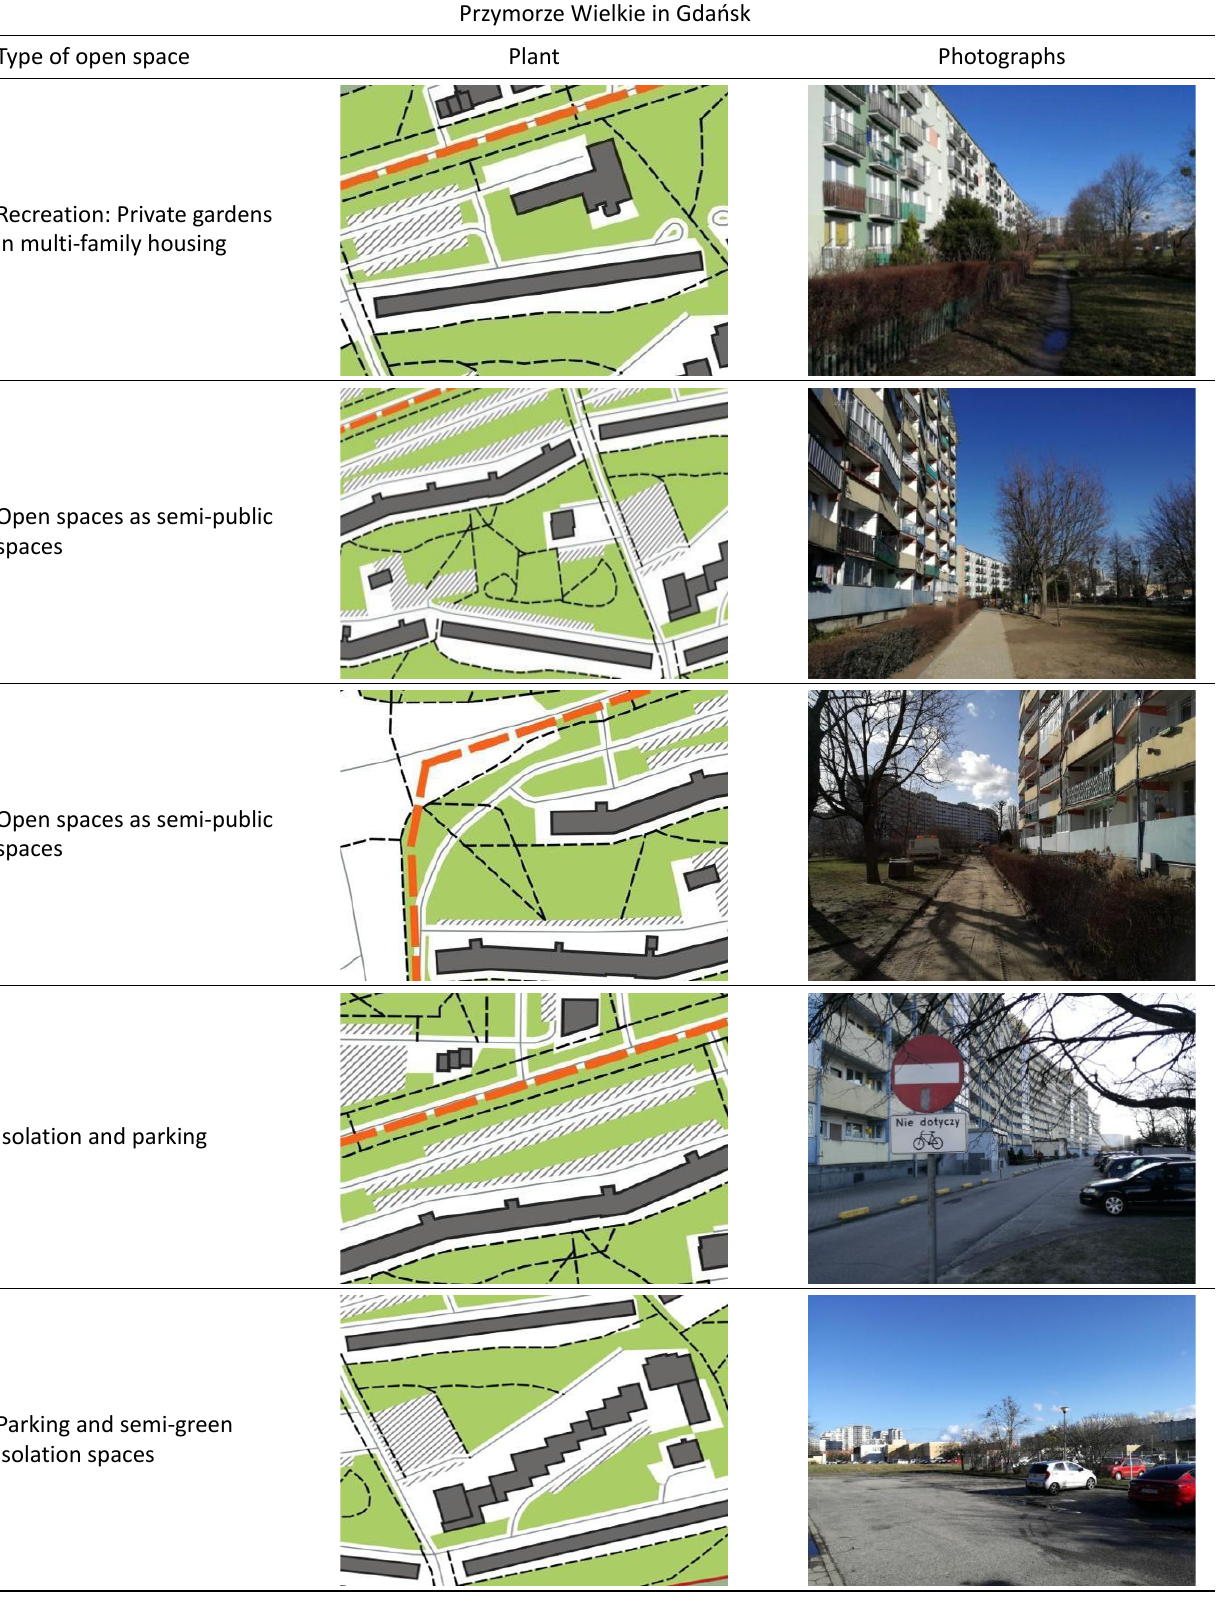
Table 3. (Cont.) Forms of open